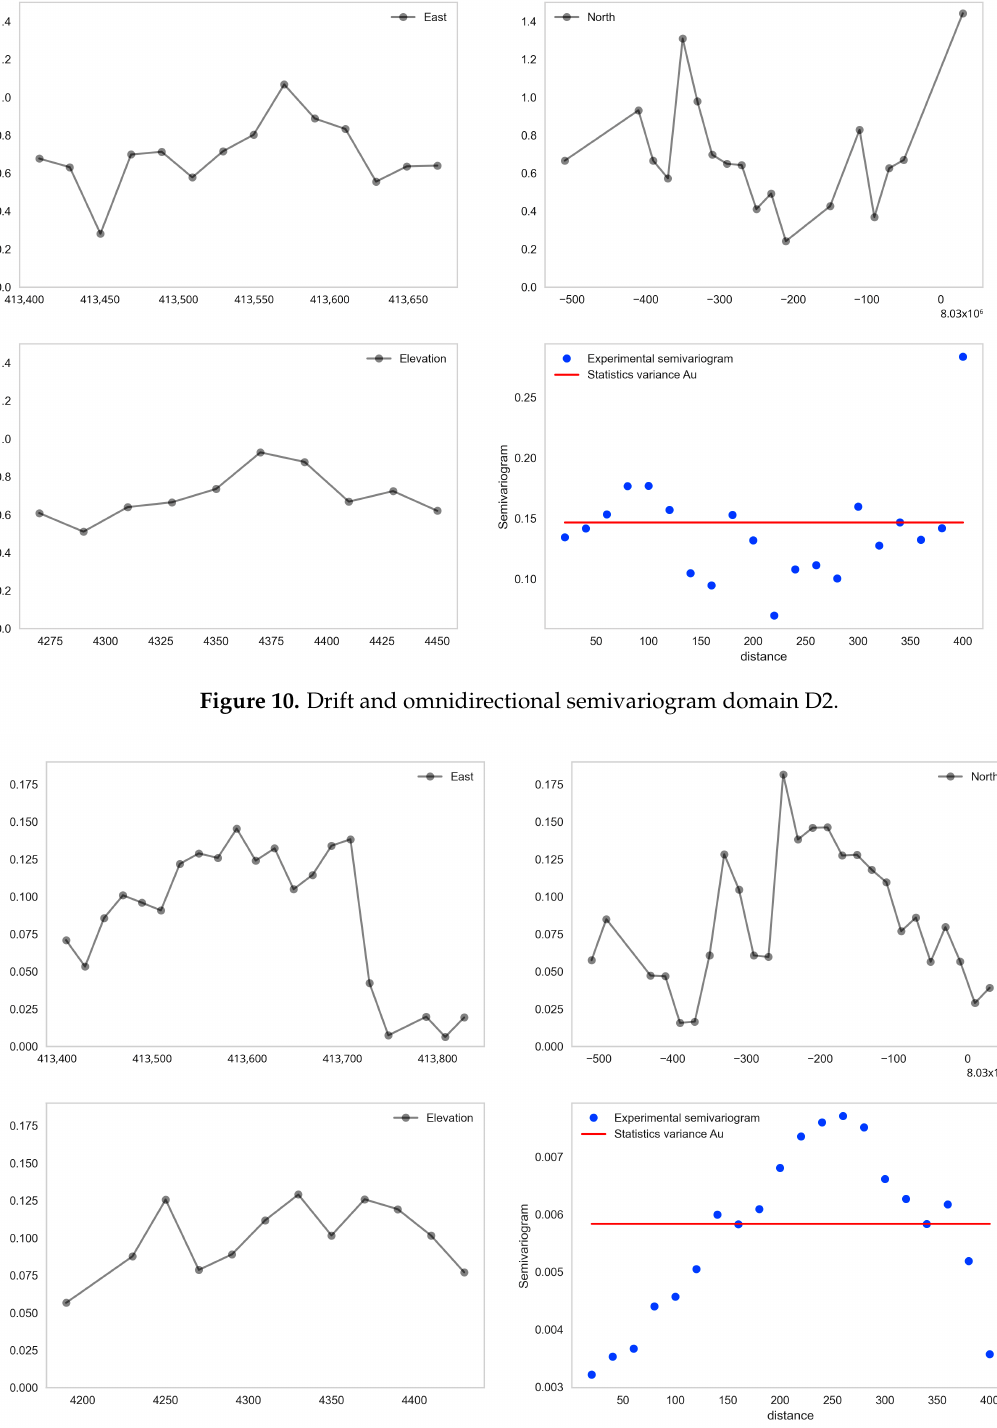
Figure 11. Drift and omnidirectional semivariogram domain